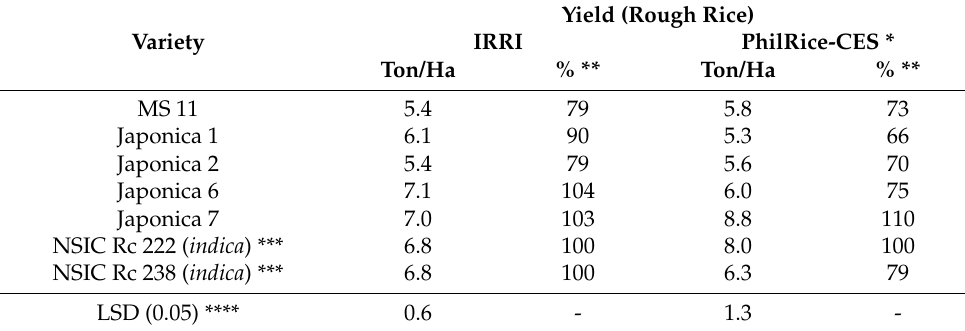
Table 4. Yields of temperate japonica rice varieties developed under the GUVA project and leading indica varieties in the 2021 dry